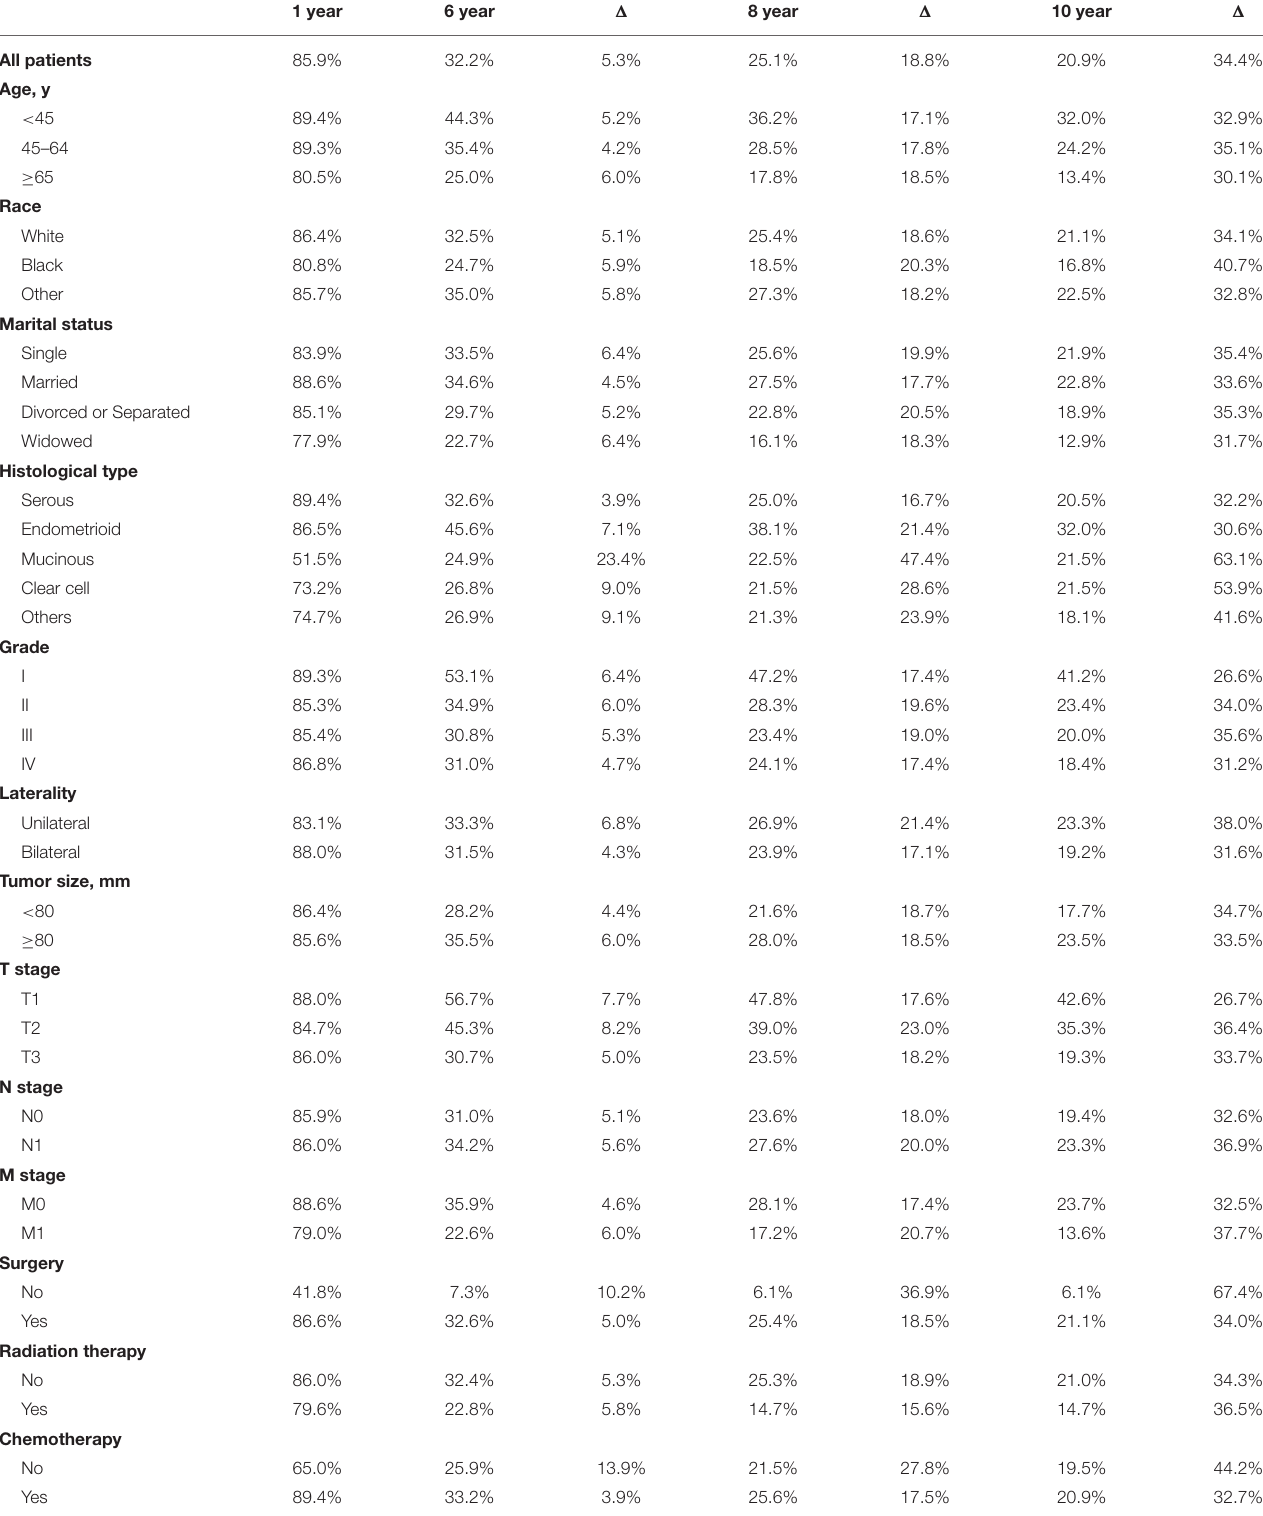
TABLE 4 | Actuarial survival rates of patients in relationship to clinical and tumor